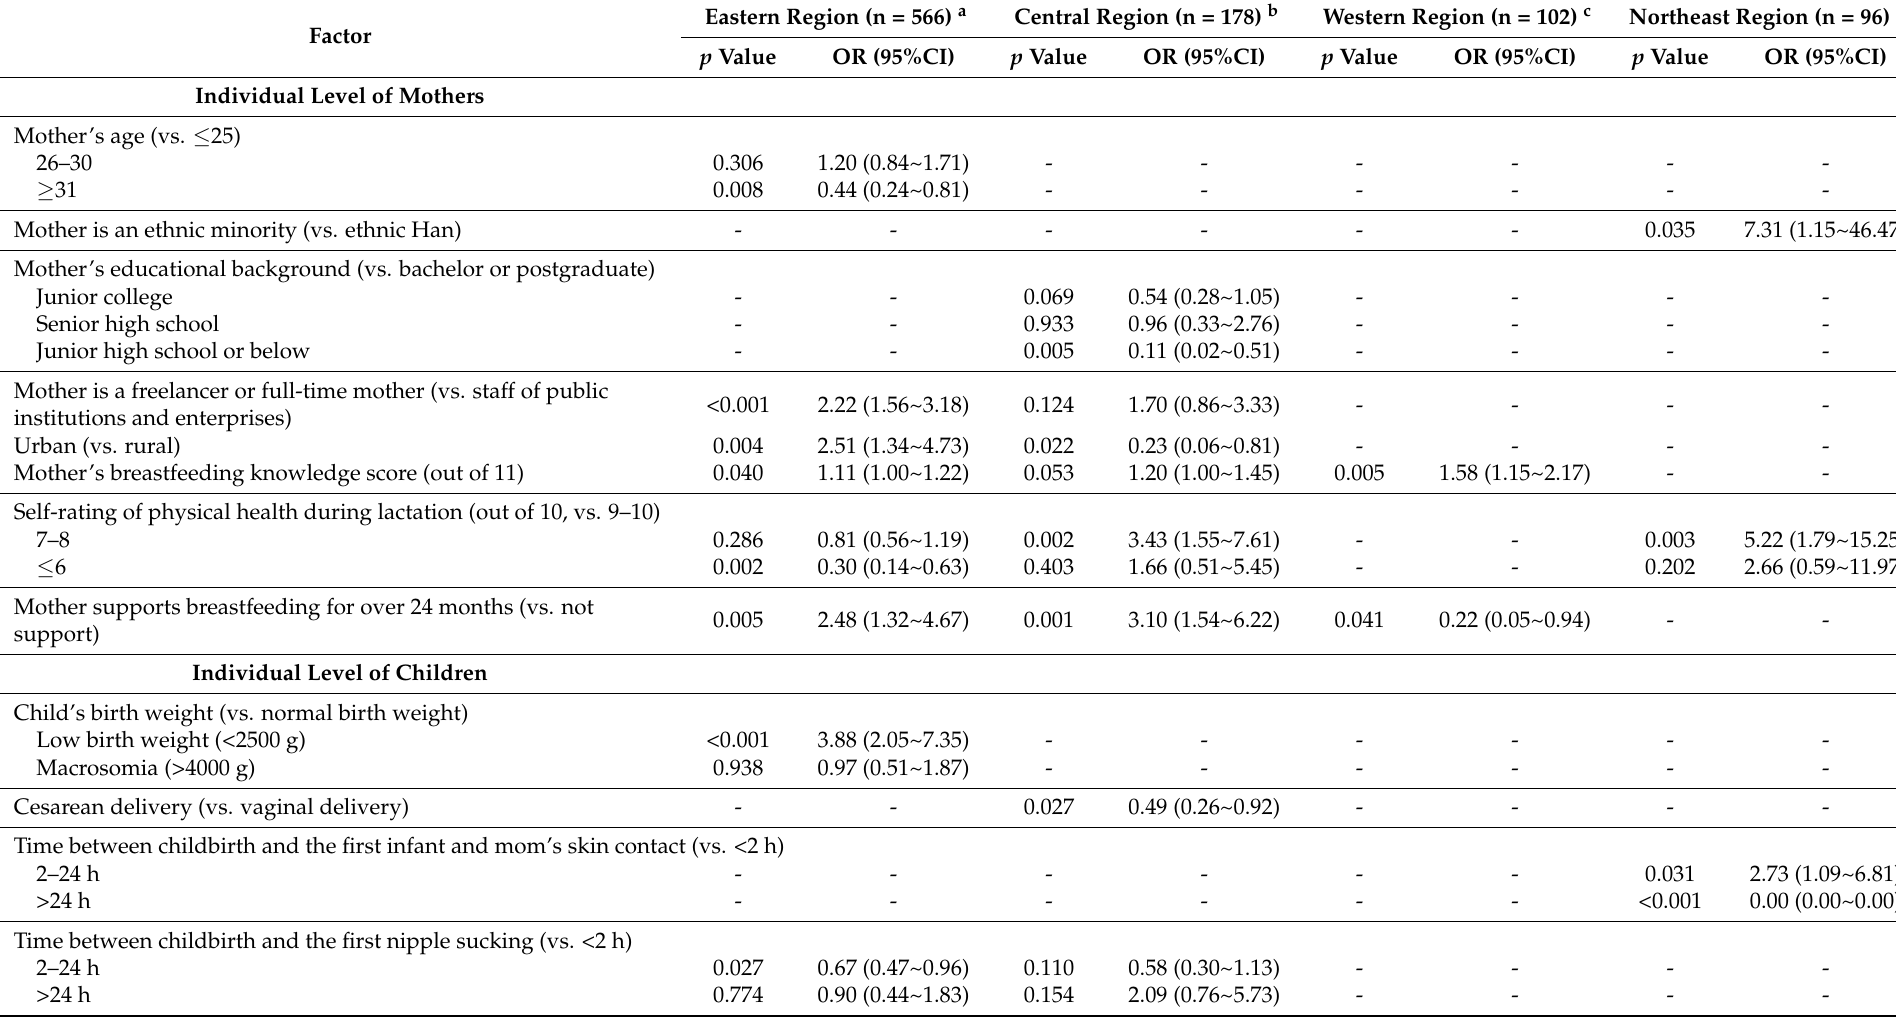
Table 3. Multivariable ordinal logistic regression of influencing factors of breastfeeding duration in different economic zones (subgroup